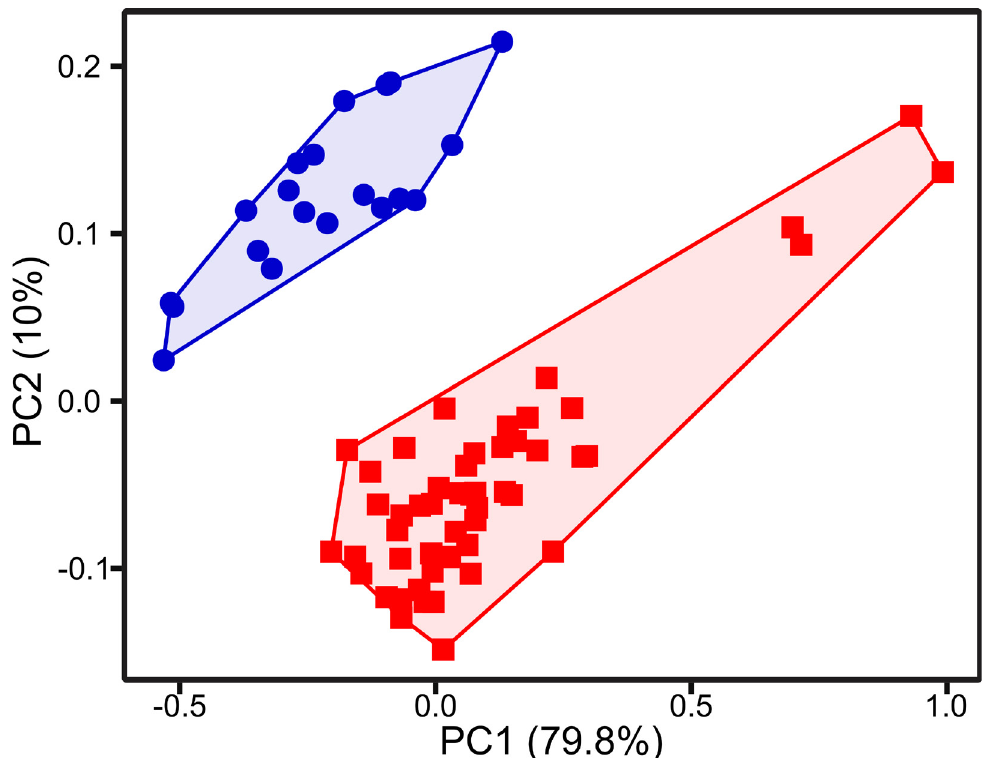
Fig. 2. Scatterplot of PC2 against PC1 of a PCA on 24 log-transformed measurements on 71 specimens of Enteromius Cope, 1867. Specimens of the genetic groups A (●) (n = 21) and B (■) (n = 50) are indicated